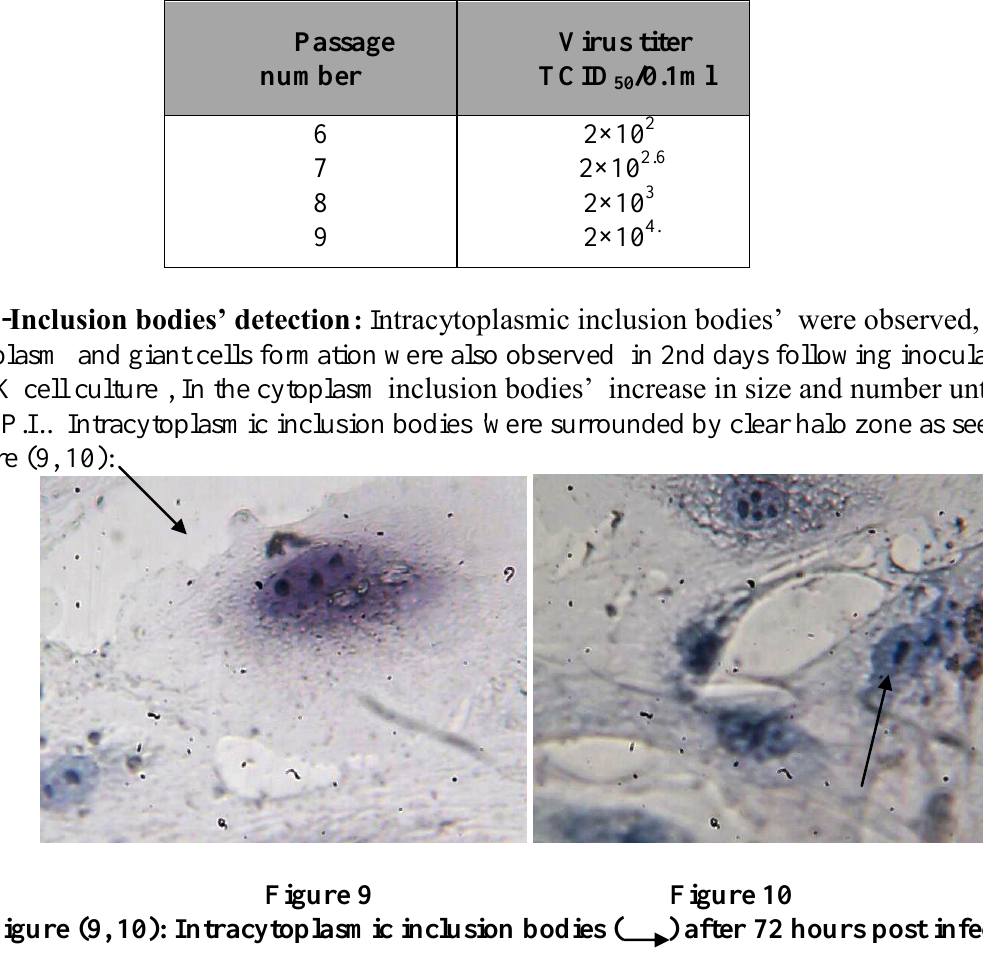
Table (1): Titration of isolated BPIV-3 in SEBK cells.